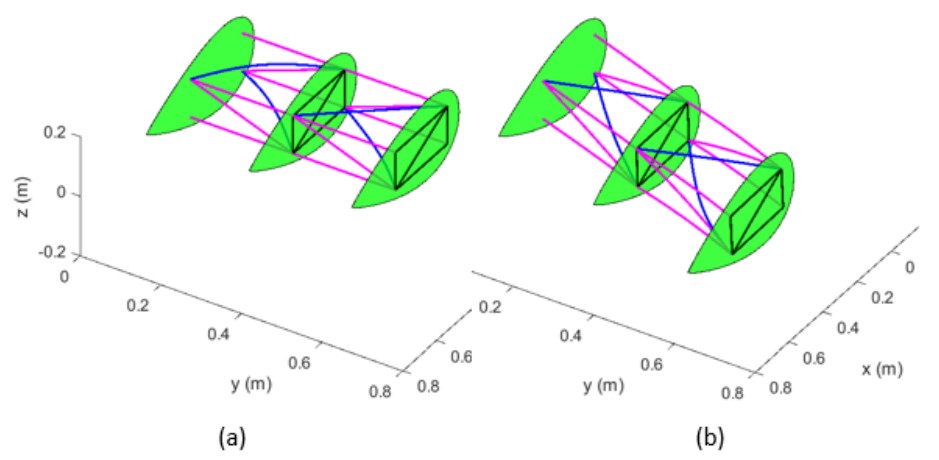
Figure 13. Fifth mode shape for the system in the ( a ) un–morphed configuration, ( b ) morphed configuration (simulation 25).